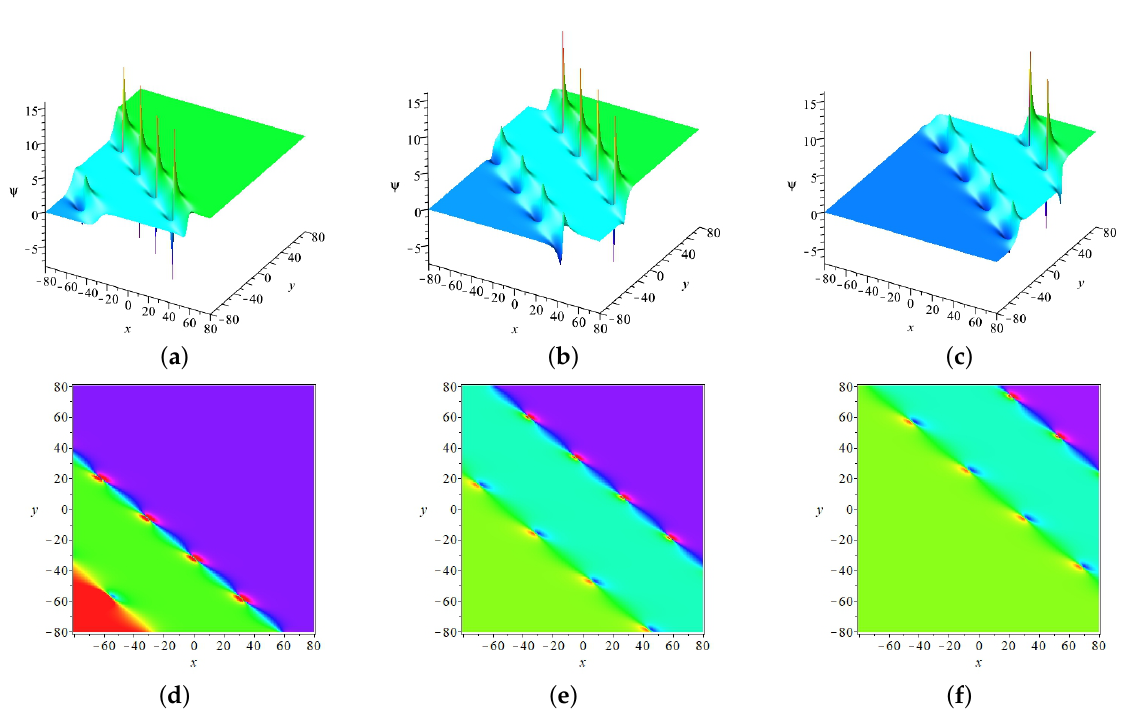
, f 2 = 2 , γ 2 = 10. ( a – c ) are vertical view when 3 3